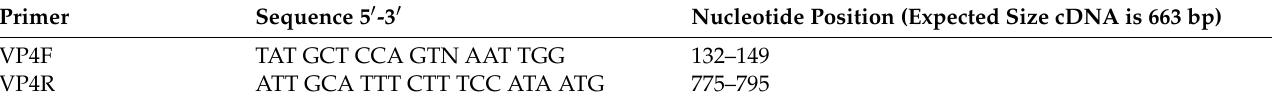
Table 2. VP4 RT-PCR Primer.